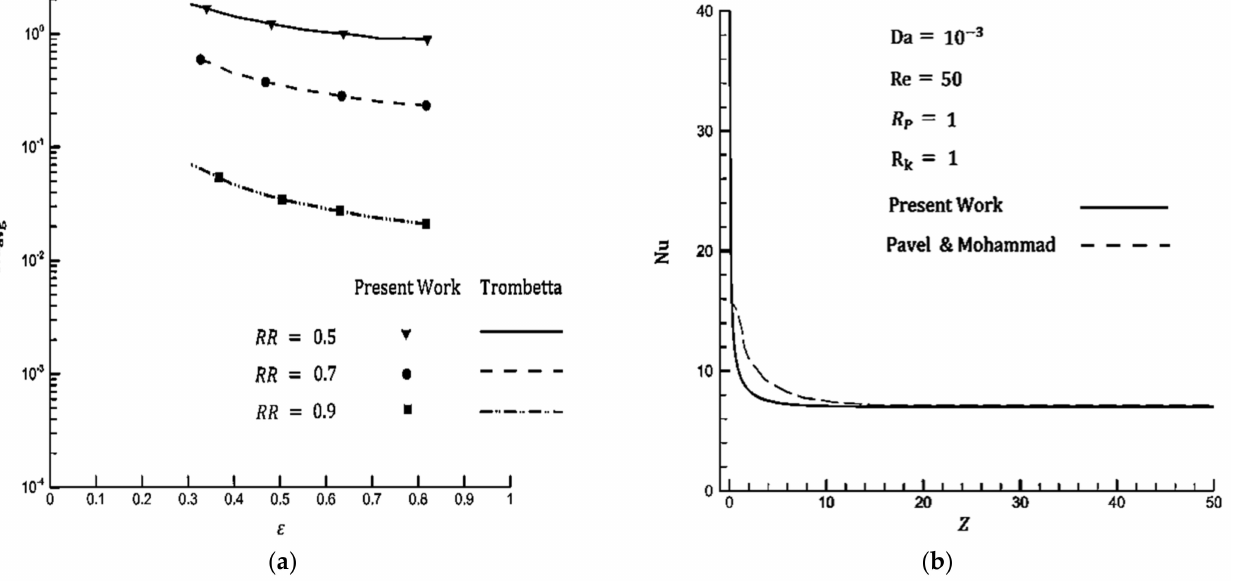
Figure 12. ( a ) Comparison of average Nusselt in an annulus with [34], and ( b ) comparison of local Nusselt in tube fully filled with porous medium with [12].